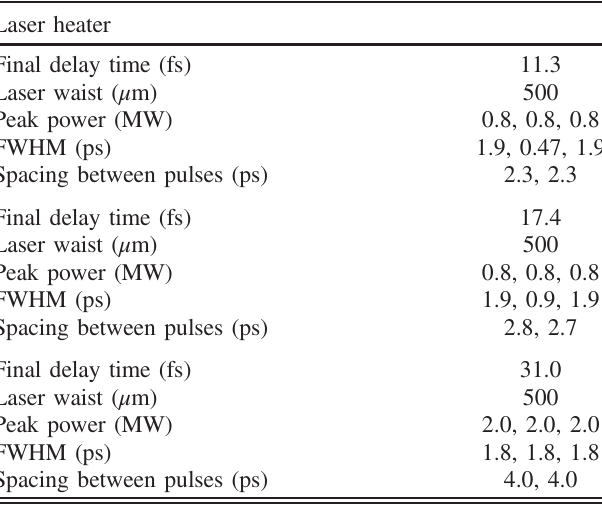
TABLE II. Laser parameters for pulse pair simulations.